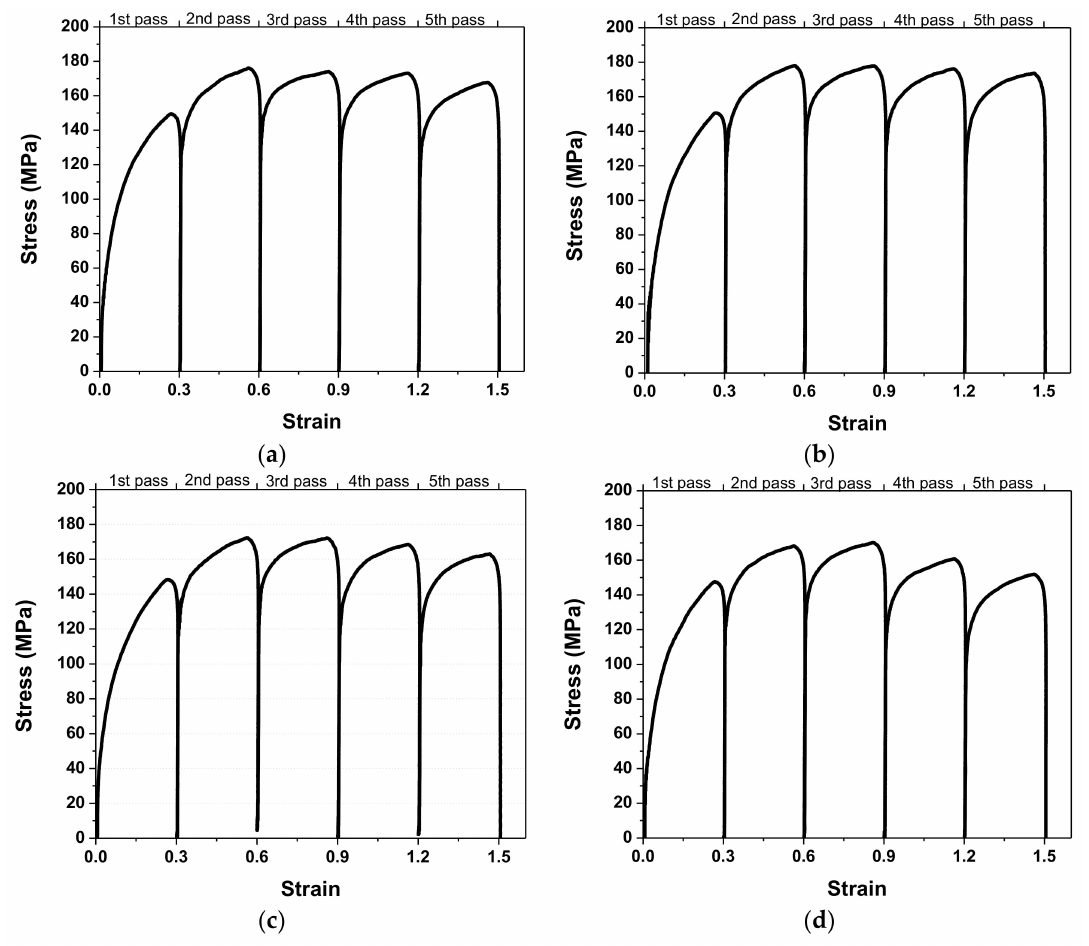
Figure 3. Stress–strain curves determined on the X70 steel according to the schedule in Figure 1 using pass strains of 0.4 applied at 1 s − 1 . Previous roughing pass numbers of ( a ) zero, ( b ) one, ( c ) two and ( d )